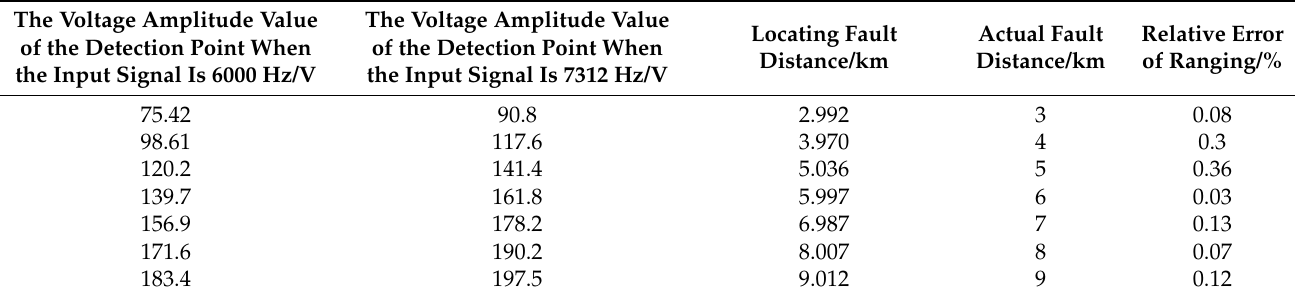
Table 2. Location results of different fault distances.